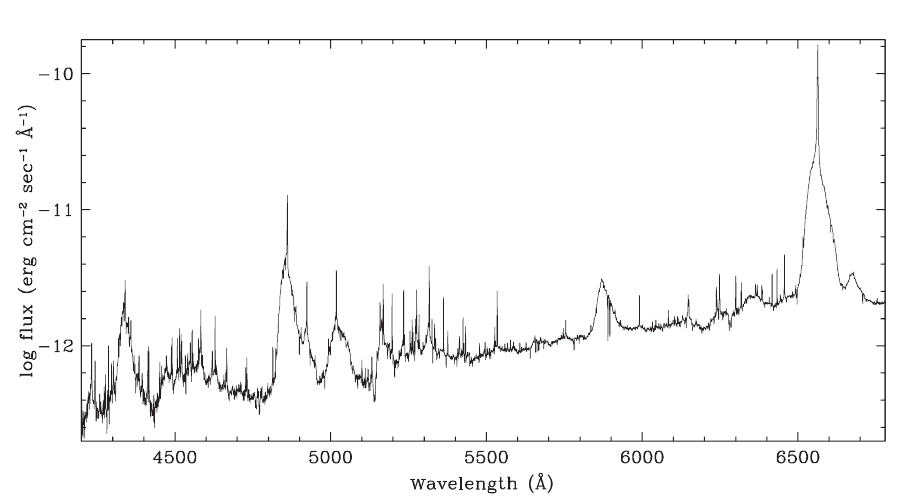
Fig. 1. A portion of an ANS Echelle high resolution spectrum of V407 Cyg for 2010 March 13 (UT 02:30), t = +2.3 days past optical maximum at V = 8.67, obtained by merging 19 adjacent Echelle orders (out of 31 recorded ones covering the 3950–8640 ˚A wavelength range) fluxed against red standards HR 7867 and HR 8228. The coexistence between the very sharp emission lines (Mira’s wind recombining after the ionization from the initial nova flash) and the broad lines (high velocity nova ejecta expanding through and colliding with the pre-existing Mira’s slow wind) is pretty